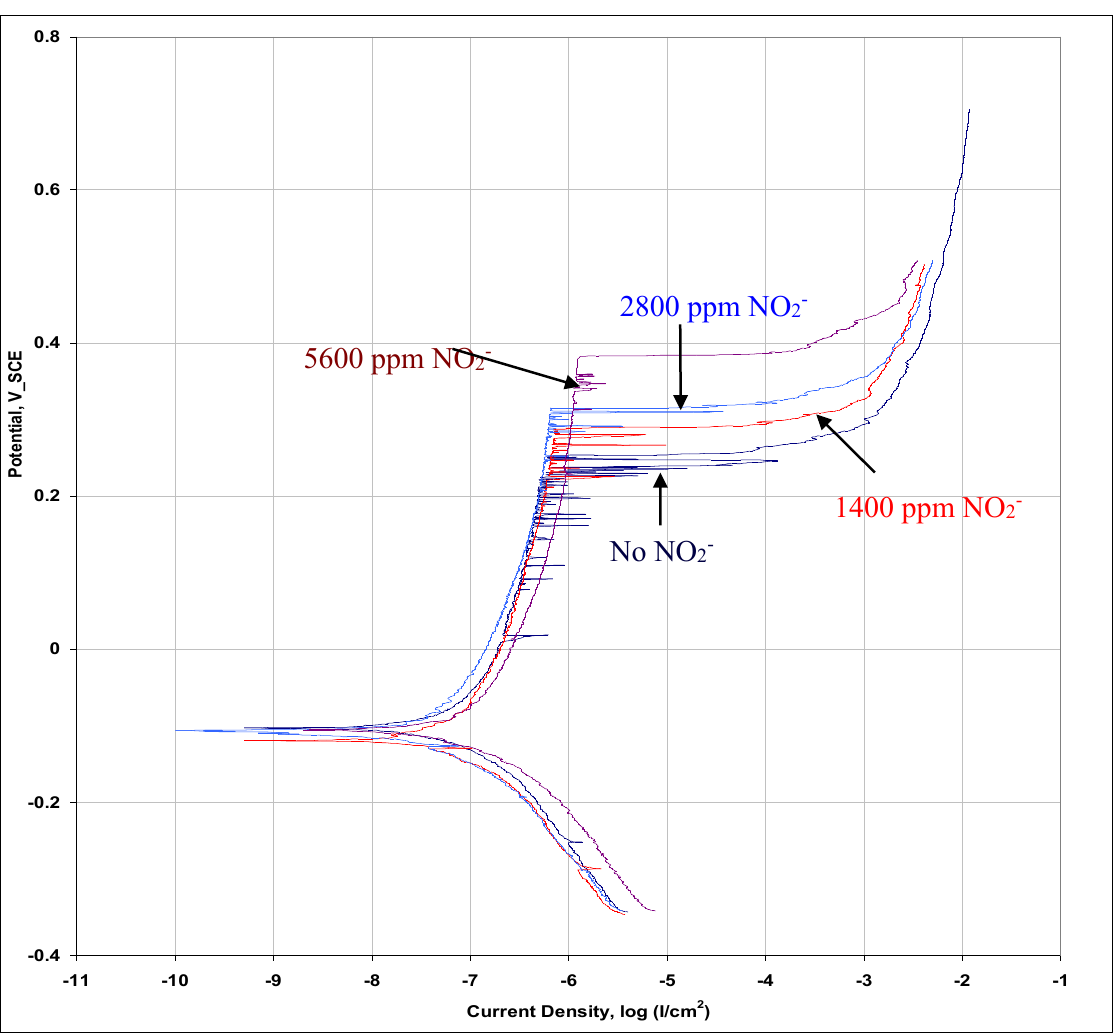
Figure 7. Anodic polarization curves of 316L in 0.1M NaCl with 0, 1400, 2800, and 5600 ppm NO 2− .